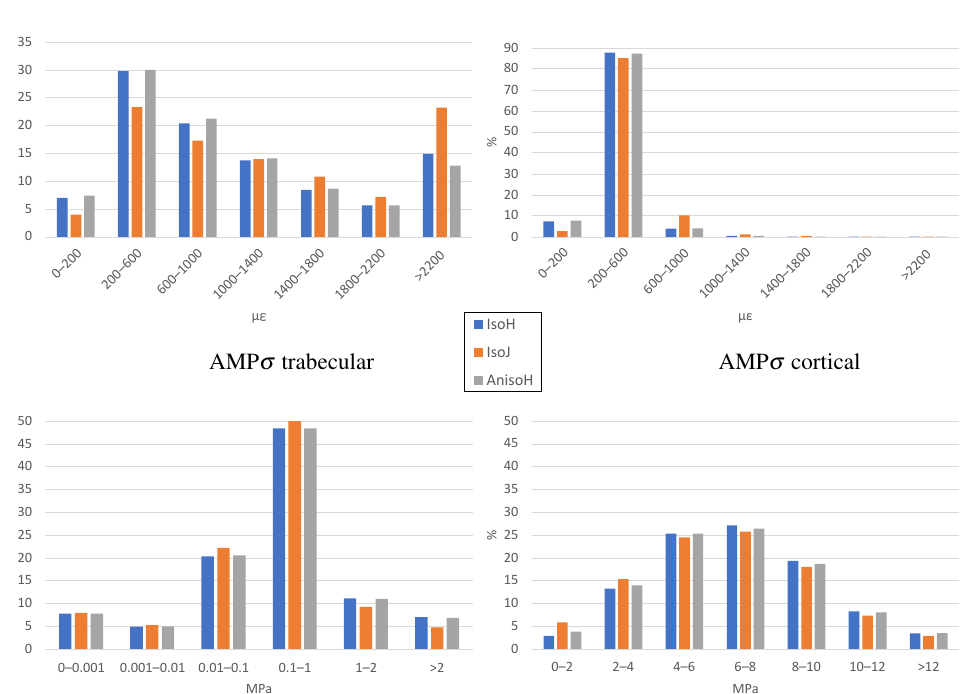
Figure 6. Distribution of the absolute maximum principal stress (AMP σ ) and strain (AMP ε ) for the elements of trabecular ( ρ 1.2 g/cm 3 ) and cortical bone ( ρ < 1.2 g/cm 3 ). The Y axis shows the ≤ percentage of the total volume occupied by the elements, whose AMP σ or AMP ε are in a given